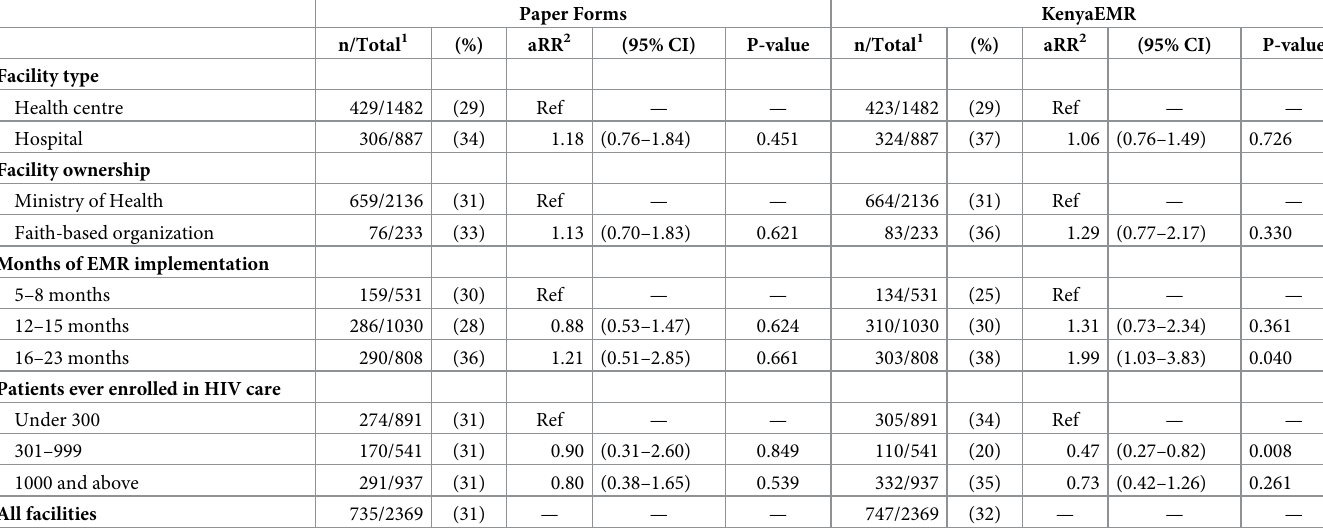
Table 2. The association between facility characteristics and the risk that records contained missing values during baseline